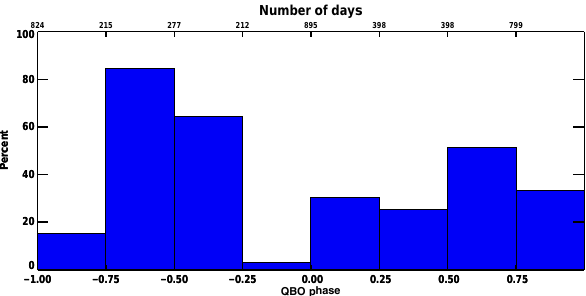
Figure 8. Percent of days in each QBO phase bin that fall between December and March. The total number of days in each bin is given along the top